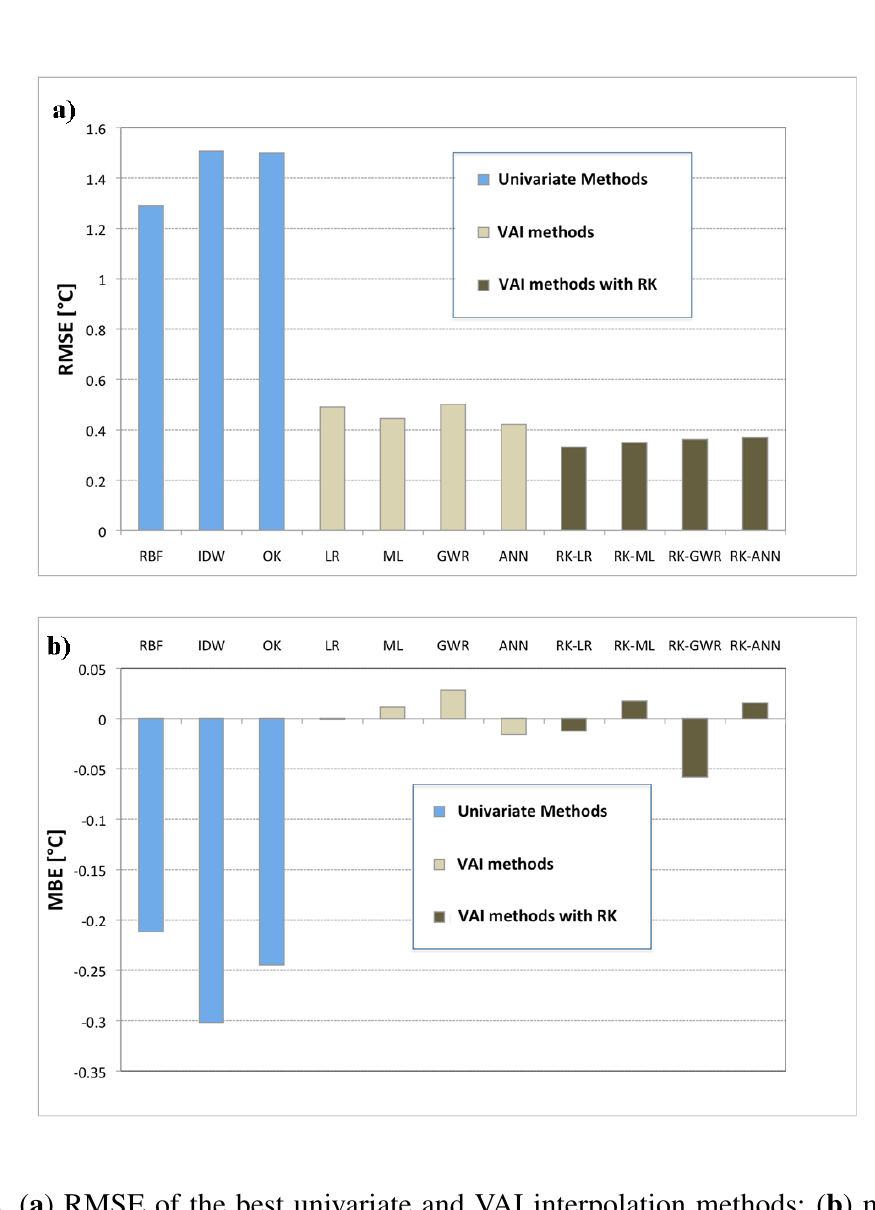
Figure 3. ( a ) RMSE of the best univariate and VAI interpolation methods; ( b ) mean bias error (MBE) of the best univariate and VAI interpolation